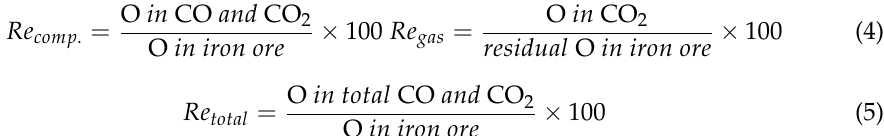
Figure 2. An example of the gas analysis during the reduction of iron ore by composite carbon. Then, the integration of the flow rates of CO and CO 2 gases with time represents the total amount of each gas from the reduction of the sample. Based on the accumulated amounts of CO and CO 2 gases in each stage, the reduction degree, Re , for the reduction by composited carbon and CO gas can be expressed as shown in Equation (4), respectively. Similarly, the reduction degree of the entire reaction can be estimated using Equa- tion (5).